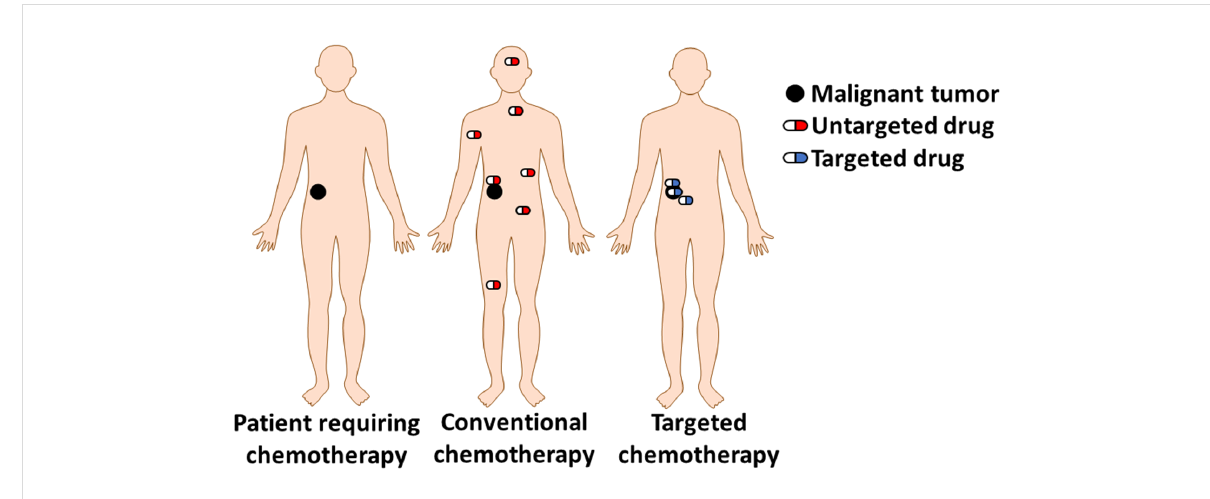
Figure 1: Conventional chemotherapy versus targeted chemotherapy. Black color = Solid malignant tumor; red = conventional untargeted cytotoxic agent; blue = targeted cytotoxic